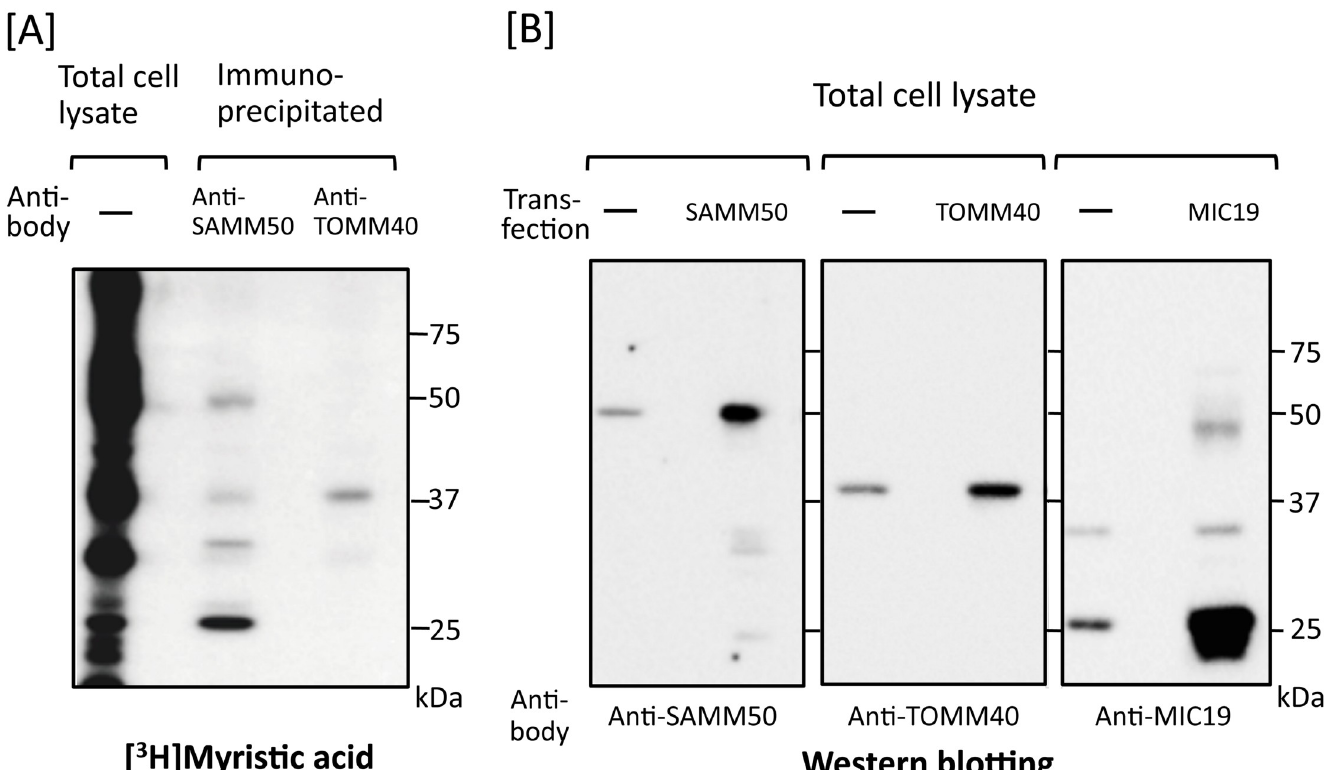
Fig 4. Endogenous SAMM50 and TOMM40 expressed in mammalian cells are N -myristoylated. A. Metabolic labeling of endogenous proteins expressed in COS-1 cells with [ 3 H]myristic acid followed by immunoprecipitation with specific antibodies against SAMM50 and TOMM40 was performed. The labeled proteins were separated by SDS-PAGE and then detected by fluorography. B. Expression of endogenous SAMM50, TOMM40, and MIC19 in COS-1 cells was determined by western blotting analysis using the respective specific antibodies. For this analysis, tag-free-SAMM50, tag-free-TOMM40, and tag-free-MIC19 exogenously expressed in COS-1 cells were used as